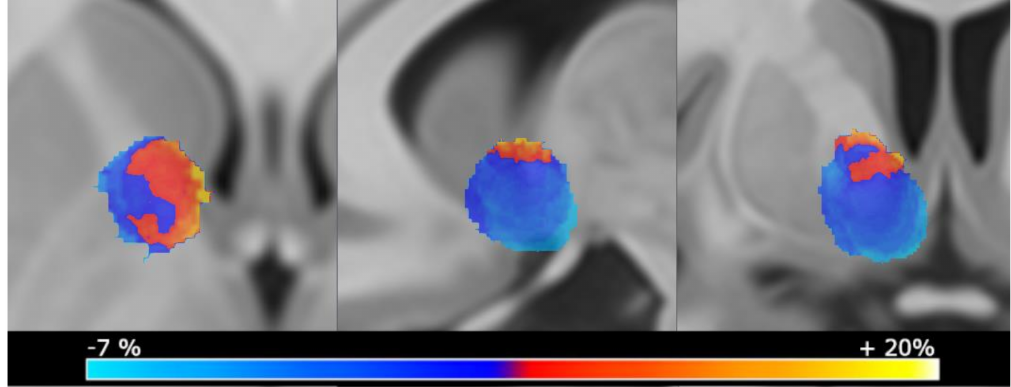
Figure 1. Averaged weight change maps displaying mean weight changes per voxel. Only voxels that were stimulated by at least 10% of the patients were selected to control for outliers. Volumes of activated tissue (VTA) that were located more medially and apically were associated with more weight gain after